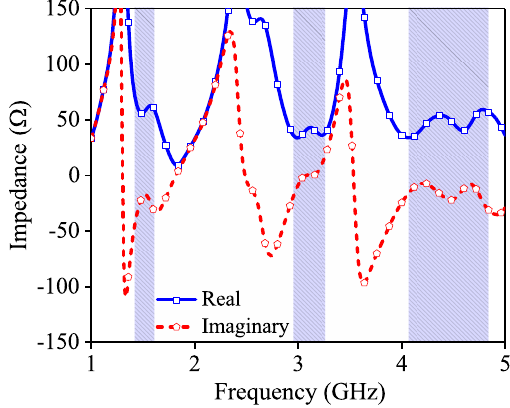
FIGURE 15: Proposed HDRA array